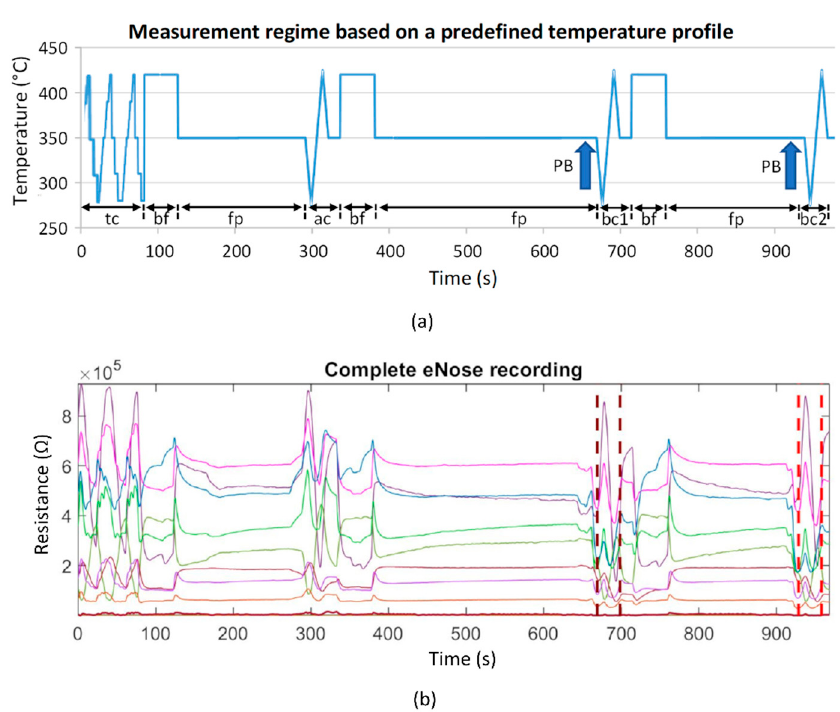
Figure 3. ( a ) Schematic representation of the measurement protocol based on a predefined temperature control of the sensor heater. It contains time-variable cyclic thermal cleaning cycles “tc”, burn-off cleaning phases “bf” (rectangle functions), subsequent flushing phases “fp” (horizontal lines), one ambient air measurement cycle “ac”, and two breathing gas measurement cycles “bc1” and “bc2”. The arrows mark the exhalation cycles (patient breathing: PB); ( b ) example of a recording of 9 sensor layer resistance curves. Vertical dashed lines mark the two breathing gas measurements.